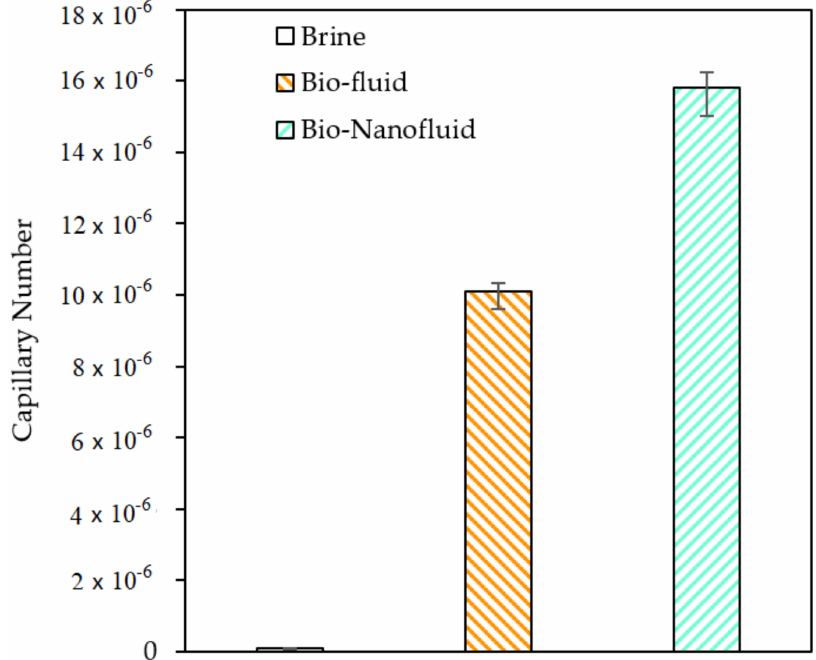
Figure 14. Estimated capillarity number ( N c ) for Brine, bio-fluid, and bio-nanofluid